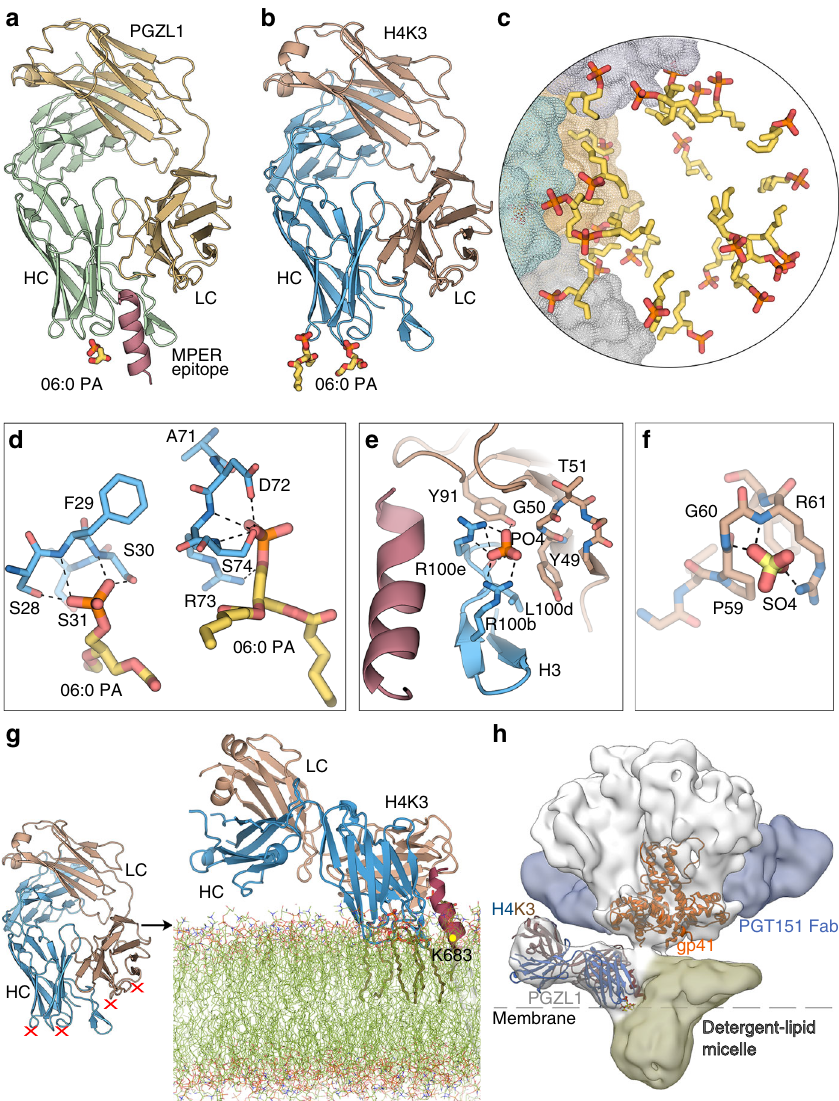
Fig. 5 Lipid binding and angle of approach of PGZL1 variants to the viral membrane. a Cartoon of the PGZL1-MPER 671-683 complex structure (wheat, LC; green, HC; pink, MPER) crystallized with 06:0 PA (sticks). b Cartoon of H4K3 (brown, LC; blue, HC) crystallized with 06:0 PA (sticks). c Stick rendering of 06:0 PA fragments forming a lipid vesicle at the interface of 12 crystallographic and non-crystallographic-related H4K3 Fabs. The four Fabs in the asymmetric unit are shown as gray, green, yellow, and blue color surfaces. d Stick rendering of observed lipid-binding sites in H4K3. e Phosphate-binding site near to H4K3 CDRH3 when MPER 671-683 (pink) is bound. Colors as in b . f Sulfate-binding site in FRL3 of H4K3. g Model of H4K3 binding to the MPER (red)-viral membrane (green) epitope. The model at the right side of the arrow was built based on the regions where experimental lipids and anions (red X) bind on H4K3 (left side of the arrow); cognate lipids are shown as sticks inside the modeled membrane. The position of the MPER K683 residue is indicated with a yellow dot. h Cryo-EM reconstruction of full-length AMC011-PGT151-PGZL1 complex at 8.9 Å with H4K3 (blue/brown ribbons) fi tted into the Env density at the base of the gp41 stem. The MPER is shown as a red ribbon and lipid head groups as sticks. The detergent – lipid micelle is shown in olive and PGT151 density in blue. Dashed lines show the approximate location where the outer surface of the membrane would be on the virus or infected